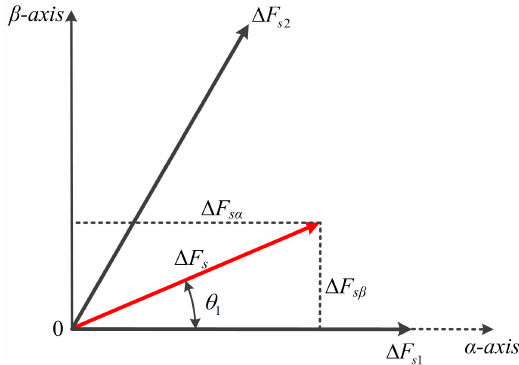
Figure 5. Analysis of error compensational effects in steady-state.